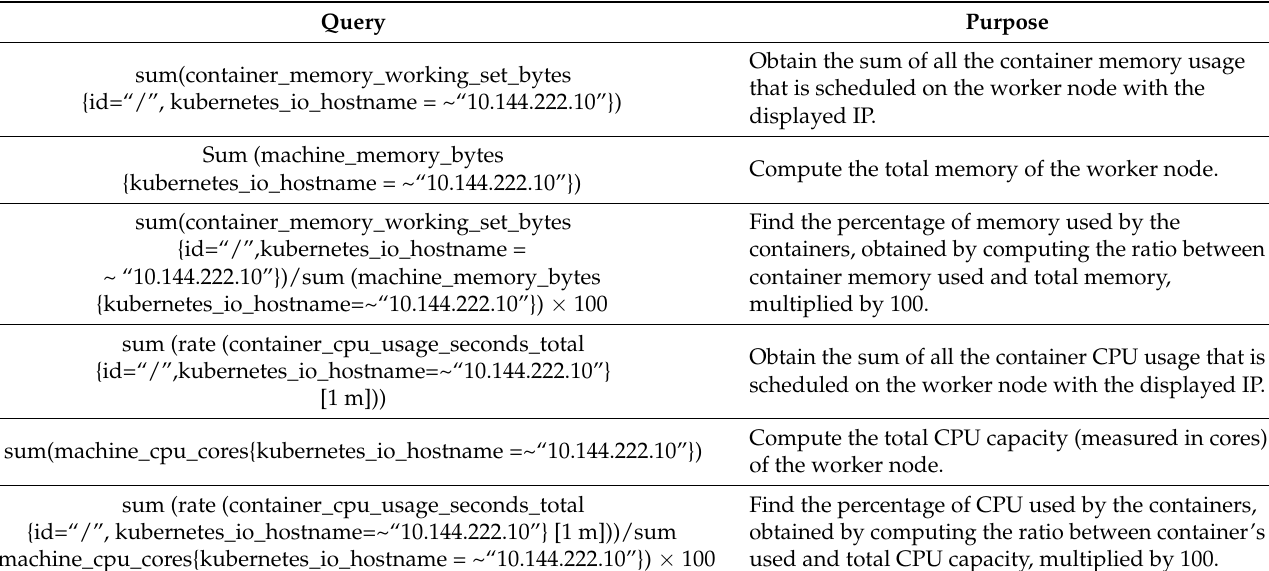
Table 3. Queries for Cluster